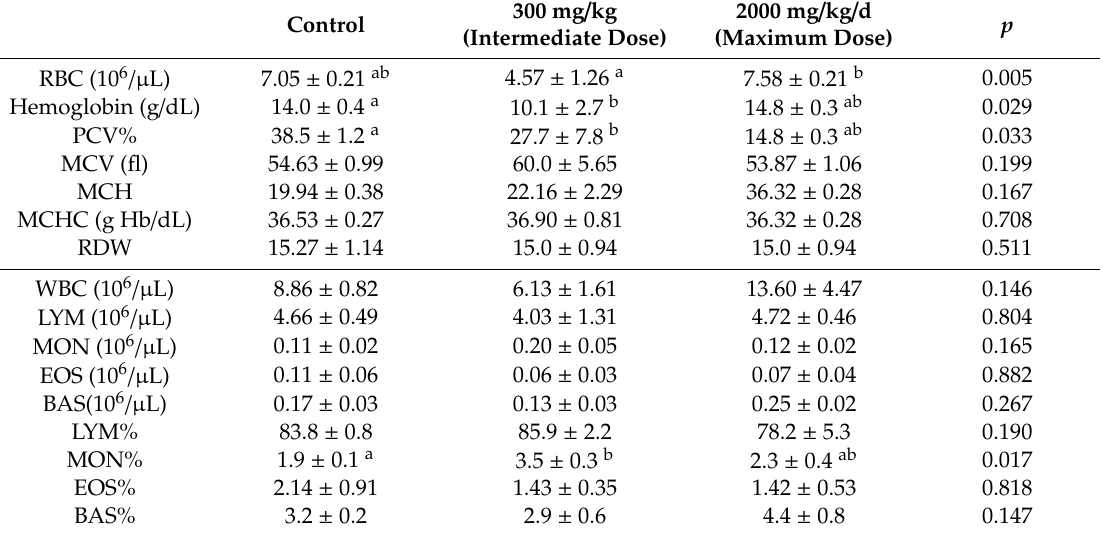
Table 1. Blood hematological parameters after 14 days of intervention with di ff erent doses of the VOO